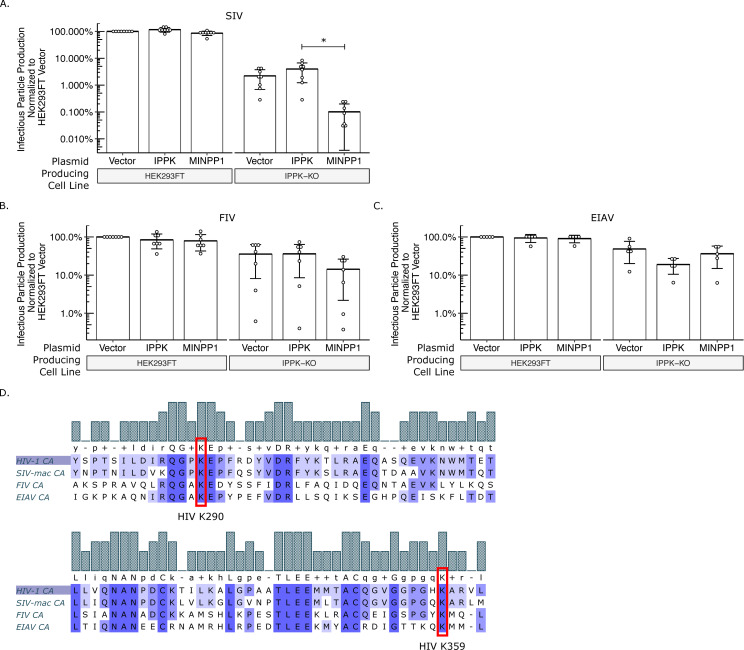
IP6 and IP5 are required assembly co-factors for primate lentiviruses.Bar charts of percent infectious particle release of lentiviruses normalized to virus from HEK293FT cells expressing the empty vector. (A) Simian immunodeficiency virus from macaques (SIV, n = 8). (B) Feline immunodeficiency virus (FIV, n = 7). (C) Equine infectious anemia virus (EIAV, n = 5). (D) Multiple sequence alignment of CA proteins of HIV-1, SIV, FIV, and EIAV. Note the homology of K290 and K359 in HIV-1 to lysines in SIV, FIV, and EIAV.